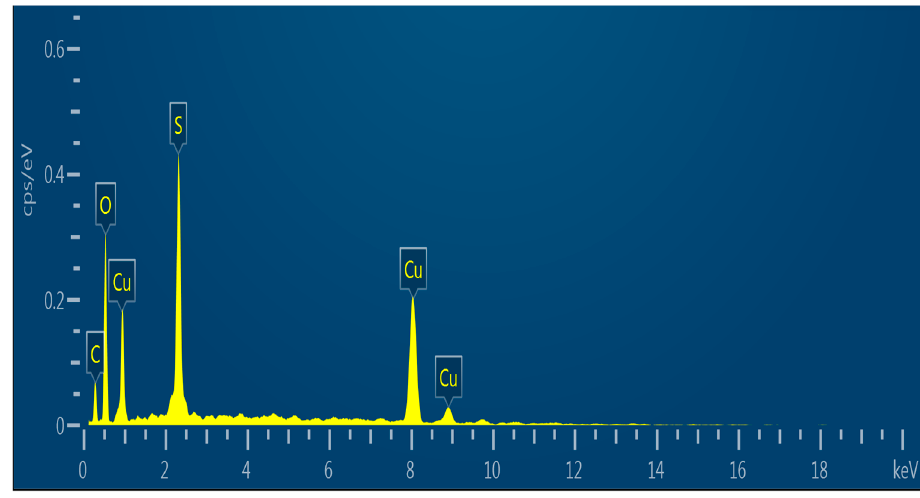
Figure 6. The EDX spectrum of CuONPs.